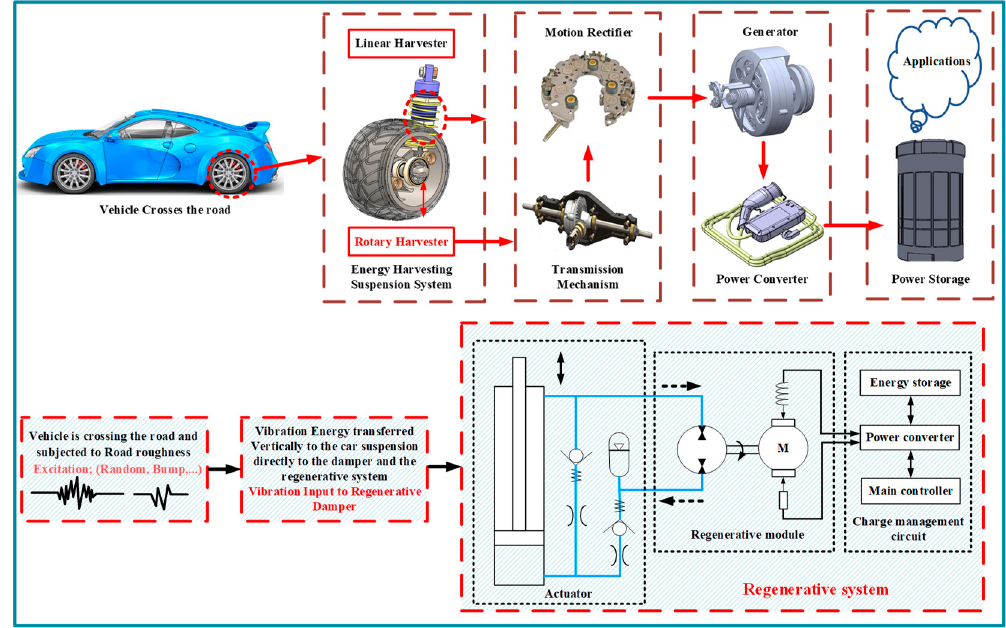
The overall scheme of the vehicle’s energy regenerative suspension system. (Reprinted (adapted) with permission from Ref. [11] Copyright (2018) Elsevier).